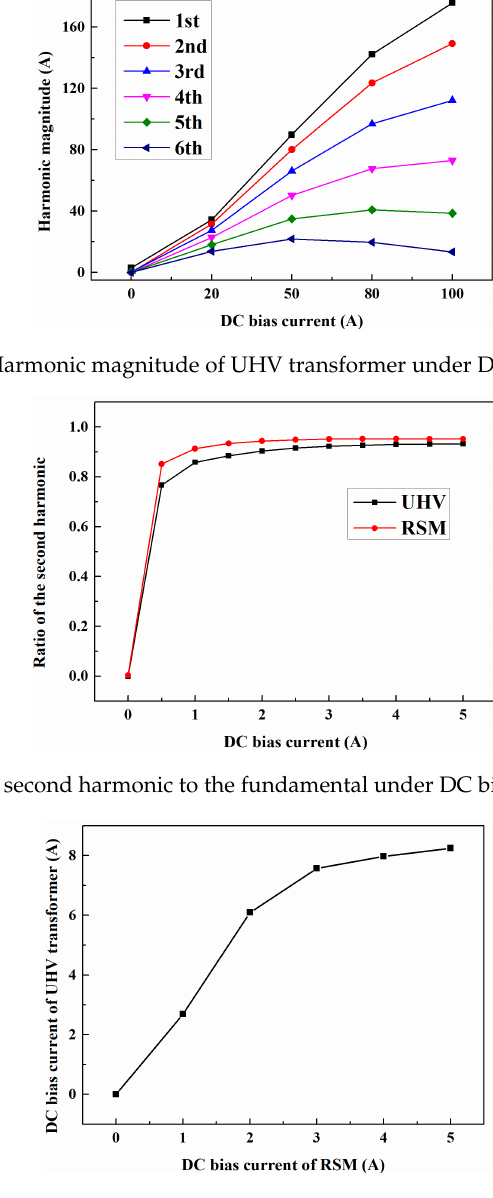
Figure 5. Excitation current waveform under DC bias current. ( a ) UHV transformer. ( b ) reduced-scale model.